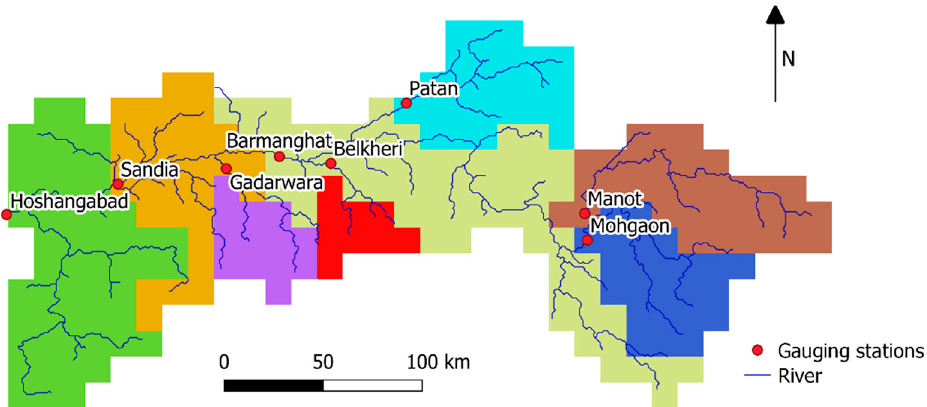
Figure 2. Drainage area for each of the eight river gauges used for the study. Note that Barmanghat, Sandia and Hoshangabad all gauge the main stem of the Narmada river. Table 3. Information on the gauged subcatchments used for this study, based on Gupta and Chakrapani [4] and Jain et al. [65].